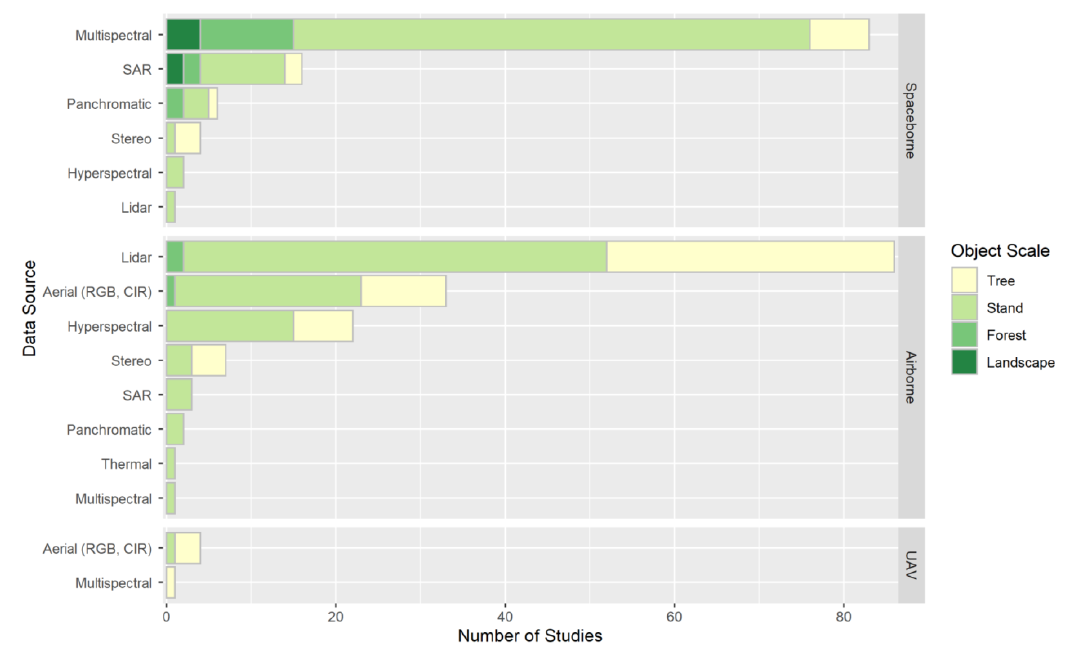
Figure 11. Number of studies in relation to the platform and sensor type by the object scale investigated. Note that studies investigating multiple object scales were counted multiple times.